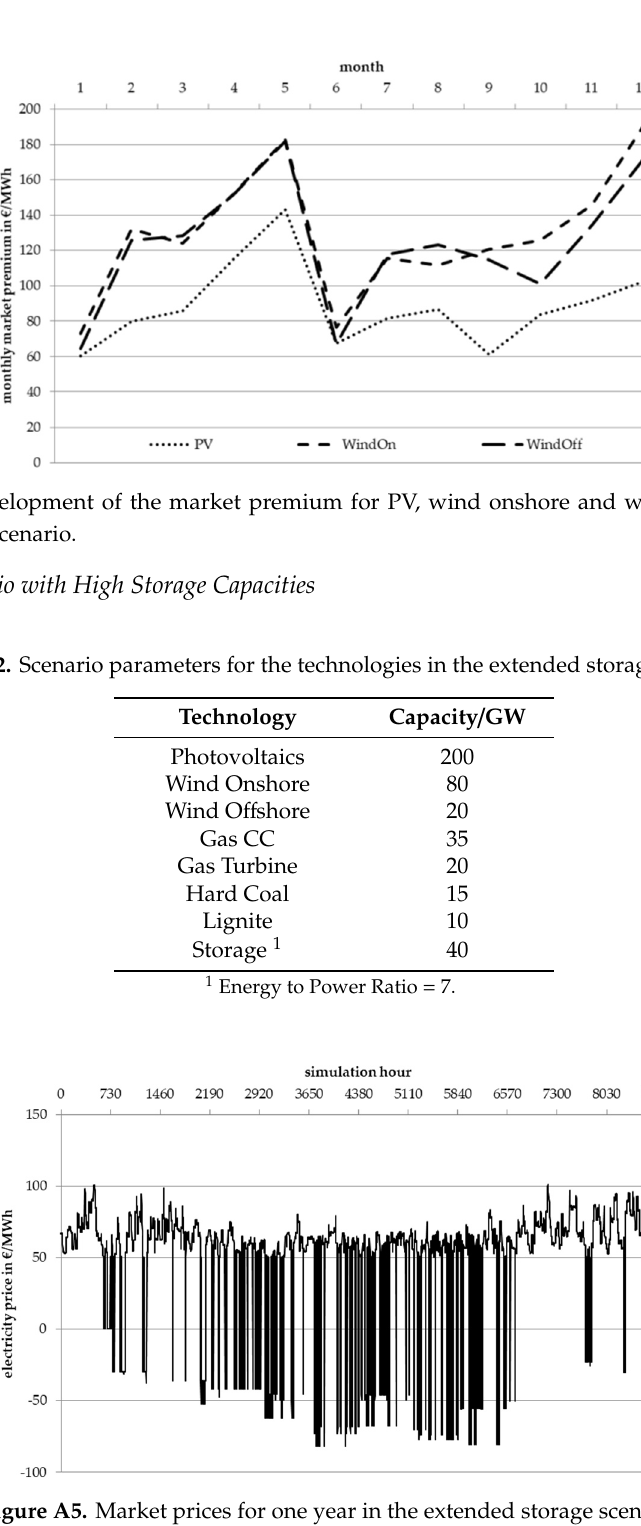
Figure A3. Development of market values for PV, wind onshore and wind offshore in the extended wind scenario.